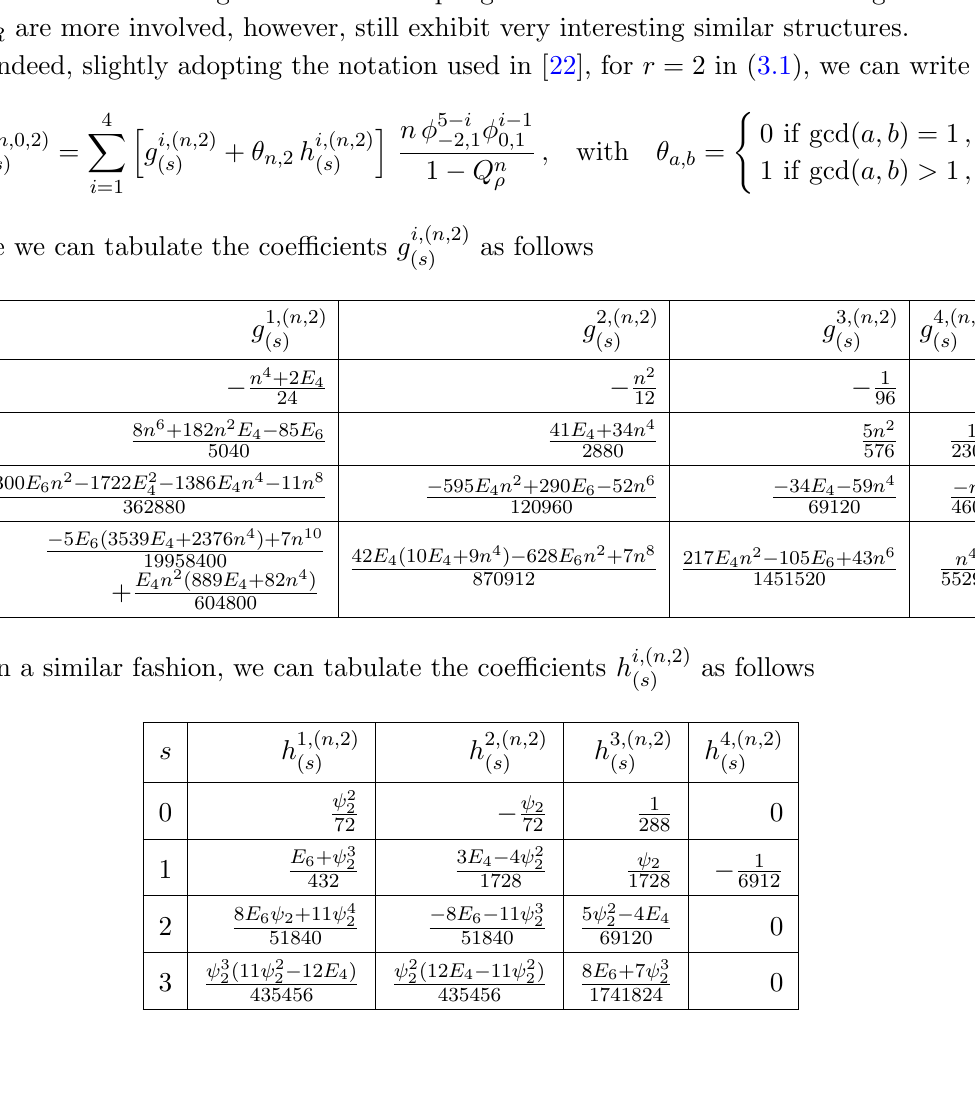
Figure 2 . Coupling function O (2) ; 0 appearing in the expansion of the free energy H (1 ; 2) of (cid:15)